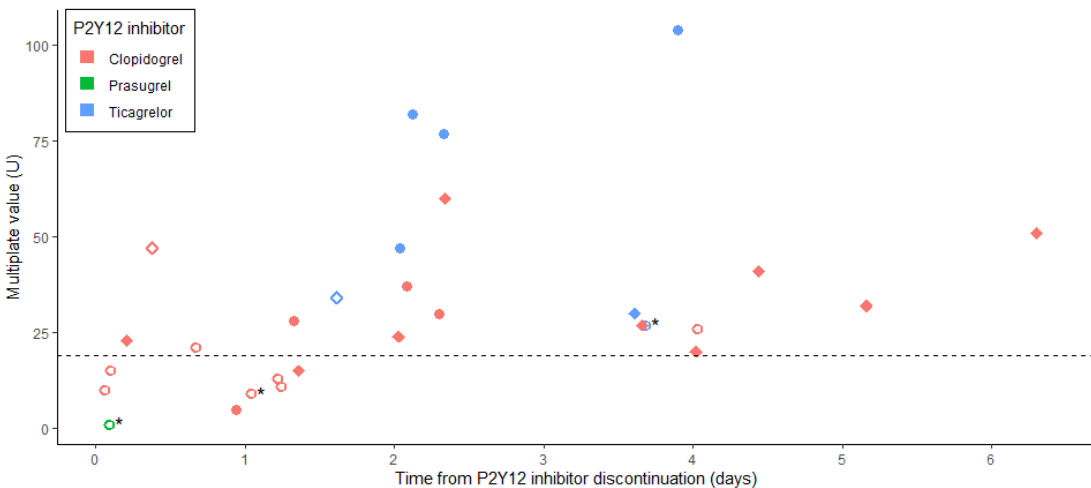
Figure 2. Last preoperative ADP–MEA result according to the duration of P2Y 12 inhibitor discontinuation. Results for cardiac surgery patients are represented as circles and those for non ‐ cardiac surgery patients as diamonds. Results for patients who have received platelet transfusion perioperatively are represented with open symbols. Dotted line represents the quantification of the area under the aggregation curve at 19 U, considered as the clinically relevant threshold. Only the last P2Y 12 inhibitor received before surgery was represented. Asterisks represent patients who received tirofiban preoperatively.